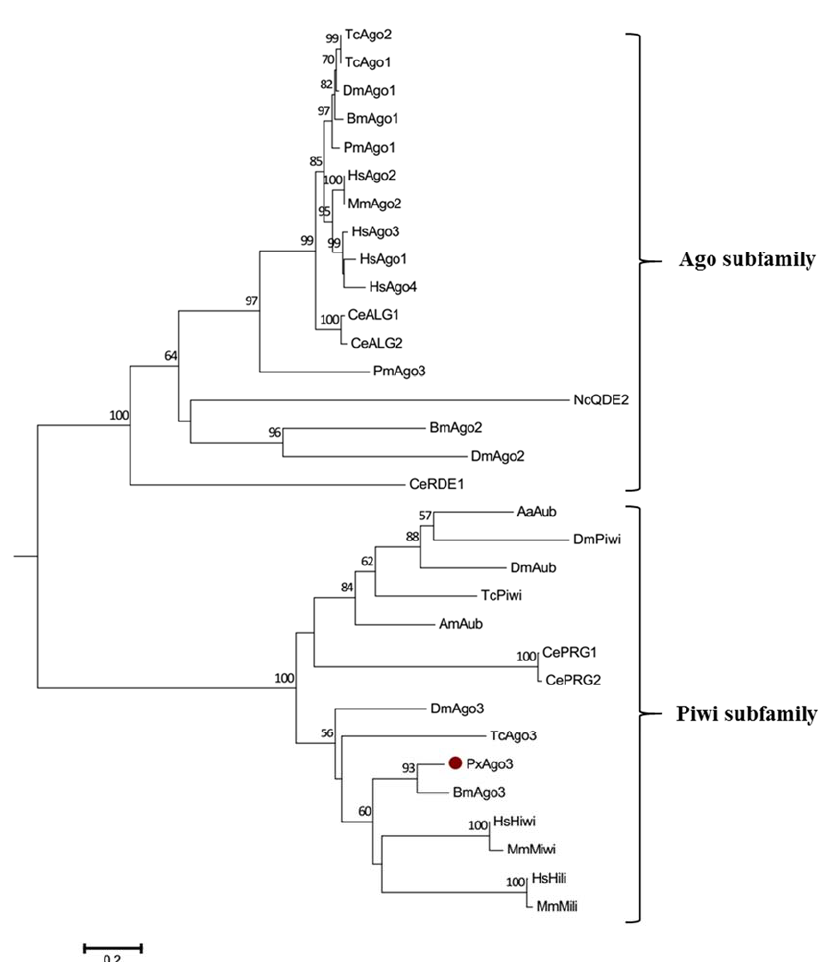
Figure 3. Phylogenetic tree of Ago proteins. The neighbor-joining tree was developed by using the MEGA 6.0 software (Molecular Evolutionary Genetics Analysis, Tokyo, Japan). The abbreviations are listed in Table 2. The bootstrap values of 1000 repeats are shown at the nodes.